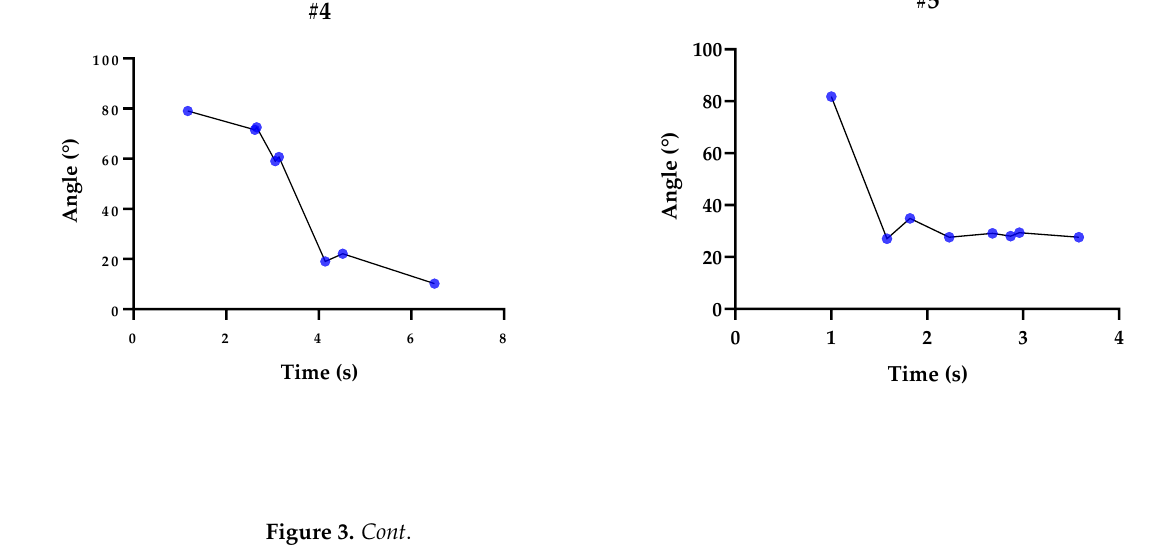
Figure 2. Representation of the pendulum tests using the inertial sensor: Flexion and extension peaks represented by the blue dots, according to the trajectory of angles ( ◦ ) and time (s) for participants #1, #2, and #3.